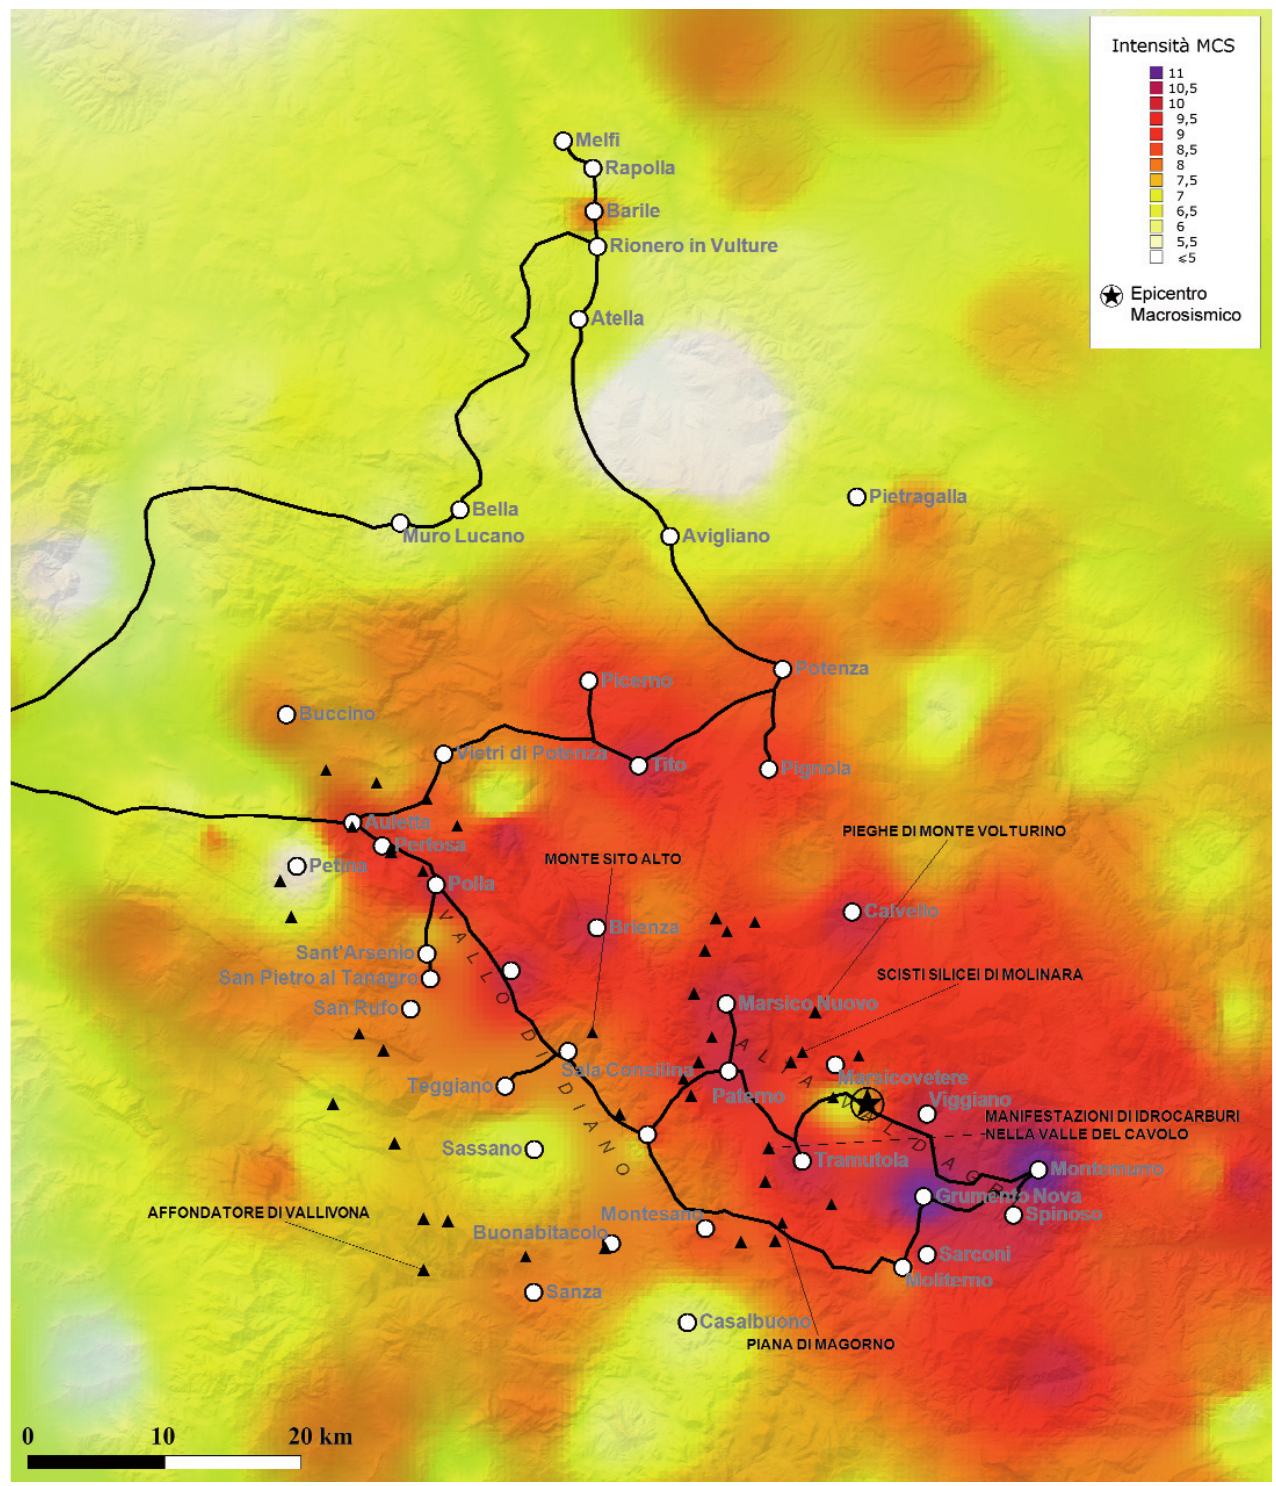
Figure 1. Summary map of the area struck by the earthquake and involved in the Mallet Project. Coloured patterns, black lines and black triangles represent the intensity distributions of the seismic effects (MCS scale), the path of Mallet’s journey, and the locations of the geosites mapped during the Project,